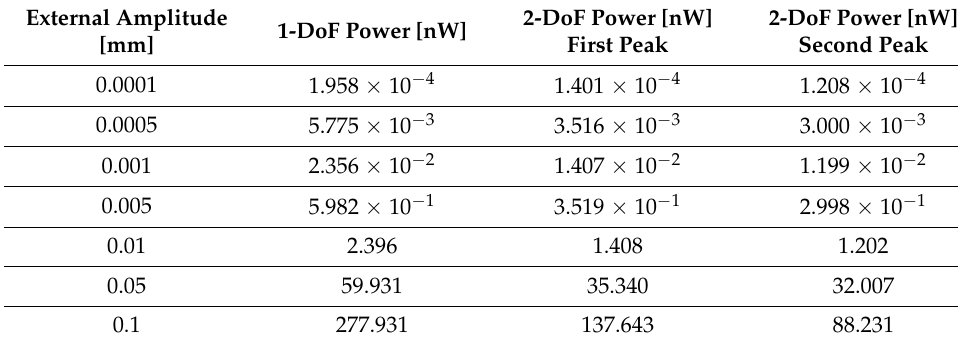
Figure 18. The amplitude as a function of the frequency of the generated power was calculated for ( a ) 1-DoF and ( b ) 2-DoF for external excitation with constant amplitude of sinusoidal force. The peak values of the electrical power for the 1-DoF and 2-DoF models for external vibration amplitude varying from 0.0001mm to 0.1 mm are shown in Table 7. For the 2-DoF, two peak values of electrical power were chosen. Table 7. Peak power for the 1-DoF and 2-DoF models.